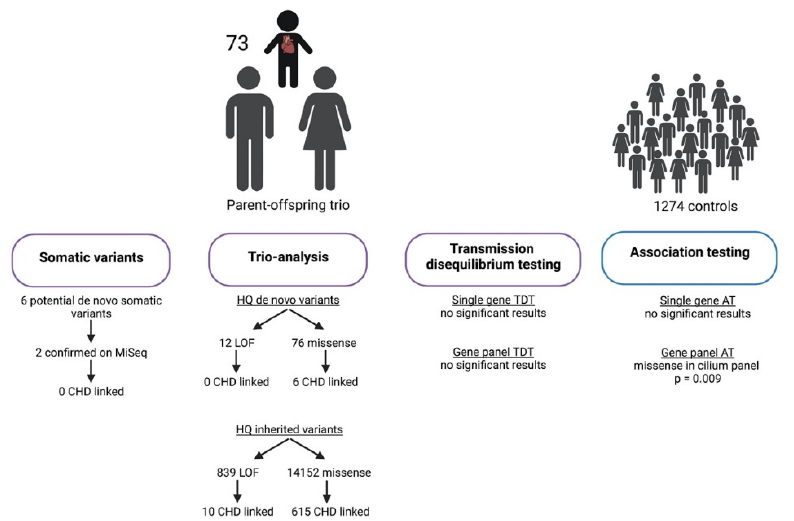
Figure 1. Overview of the study cohort and the results of the study analyses. Figure created with Biorender.com.